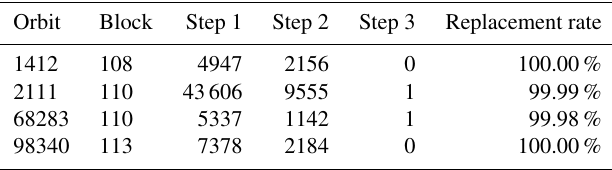
Table 2. Confusion matrix for P168, O092981, B101, camera AF (where P is Path, O is Orbit and B is